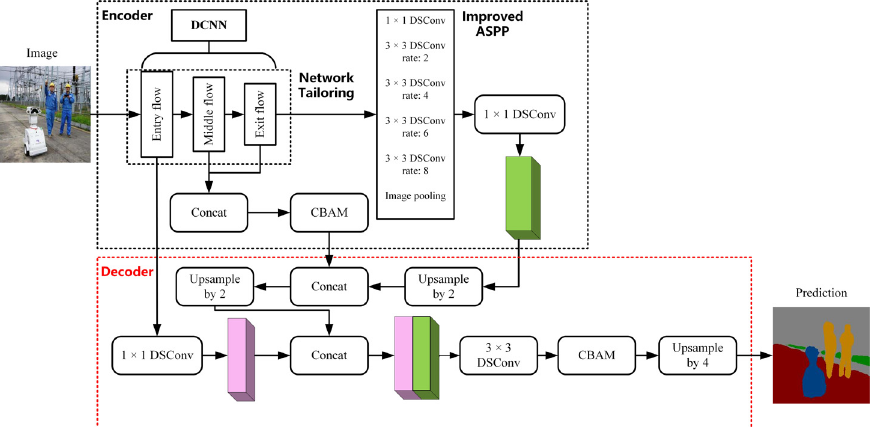
Figure 4. Improved DeepLab V3+ network